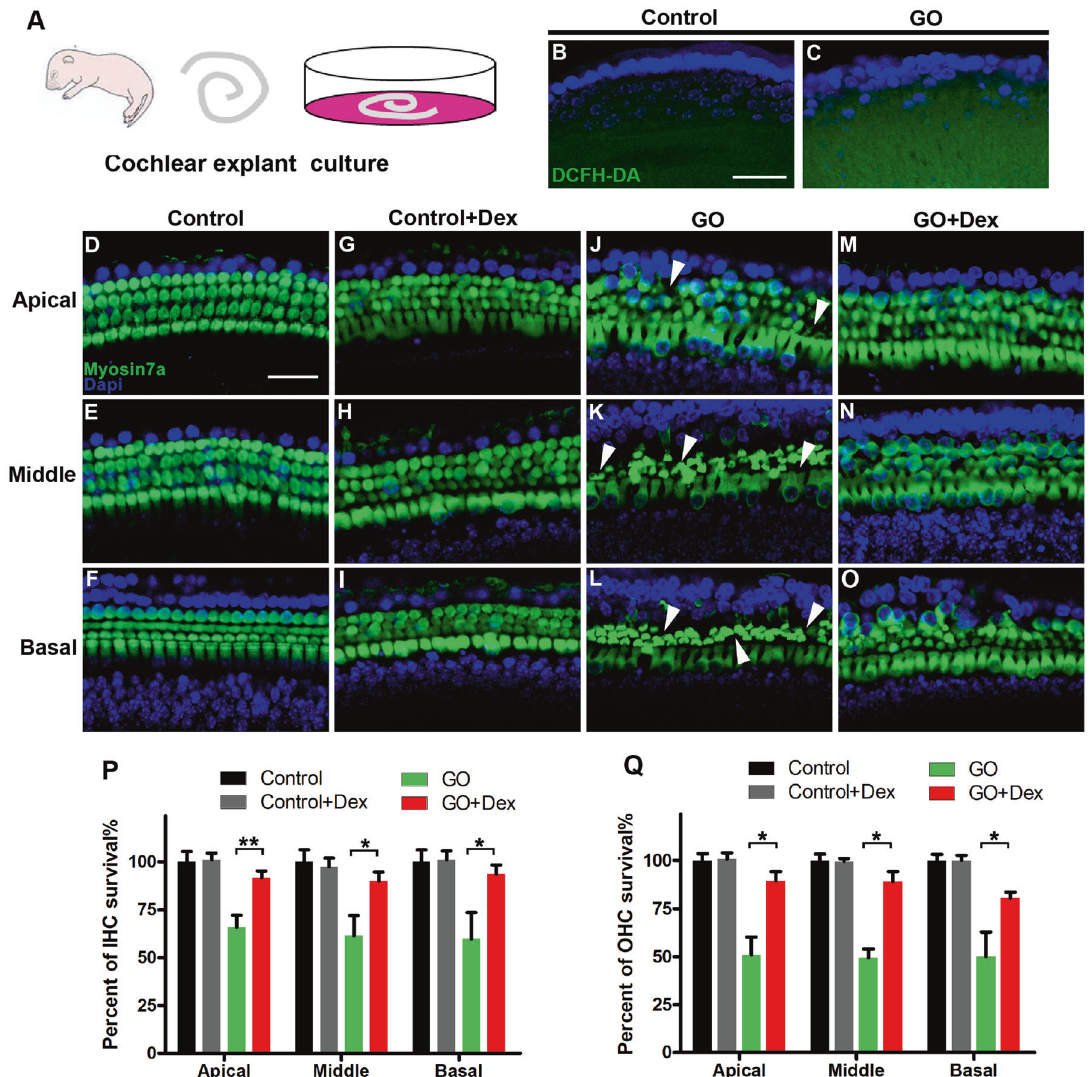
Fig. 1 Effects of dexamethasone on glucose oxidase-induced hair cell loss in vitro. A Diagram of cochlear explants culture, cochlear basilar membrane dissected from C57BL/6 mice at P3 and cultured in vitro. B , C The intracellular ROS level was measured with peroxide-sensitive fl uorescent probe DCFH-DA in control group and GO group. D – O Immuno fl uorescence staining with myosin 7a (green) and DAPI (blue) in different turns of the cochleae from different group. Representative images of the control group, DEX, GO, and GO + DEX group are shown. The white arrowheads in panels J – L indicate the degeneration of hair cells. P Quanti fi cation of the survival rate of IHCs in different treatment groups. Q Quanti fi cation of the survival rate of OHCs in different treatment groups. Data are shown as the mean ± SD, n = 5 cochlear explants in each group, ** P < 0.01, * P < 0.05. Scale in panels ( B ) and ( D ) represents for 40 μ